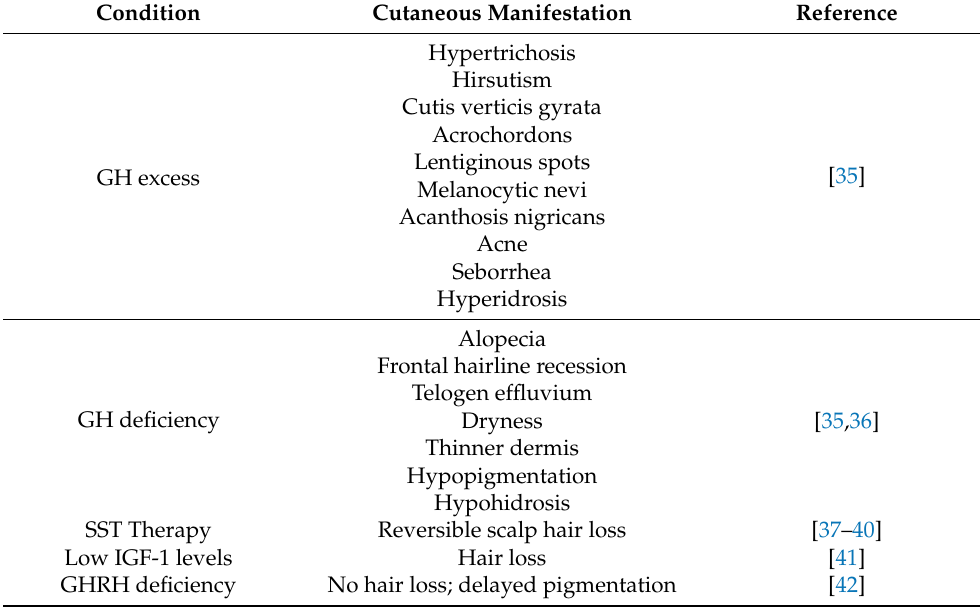
Table 2. Well-documented cutaneous manifestations of GH excess and deficiency in human skin. First listed is growth hormone (GH) excess, leading to acromegaly or gigantism, as seen in soma- totroph adenoma of the anterior pituitary, neurofibromatosis-1, McCune Albright syndrome, multiple endocrine neoplasia type 1, Carney complex, and others. Then listed is growth hormone deficiency, as seen in Noonan syndrome, Turner syndrome, Prader–Willi Syndrome, and Laron syndrome, referenced from Kanaka-Gantenbein et al.,